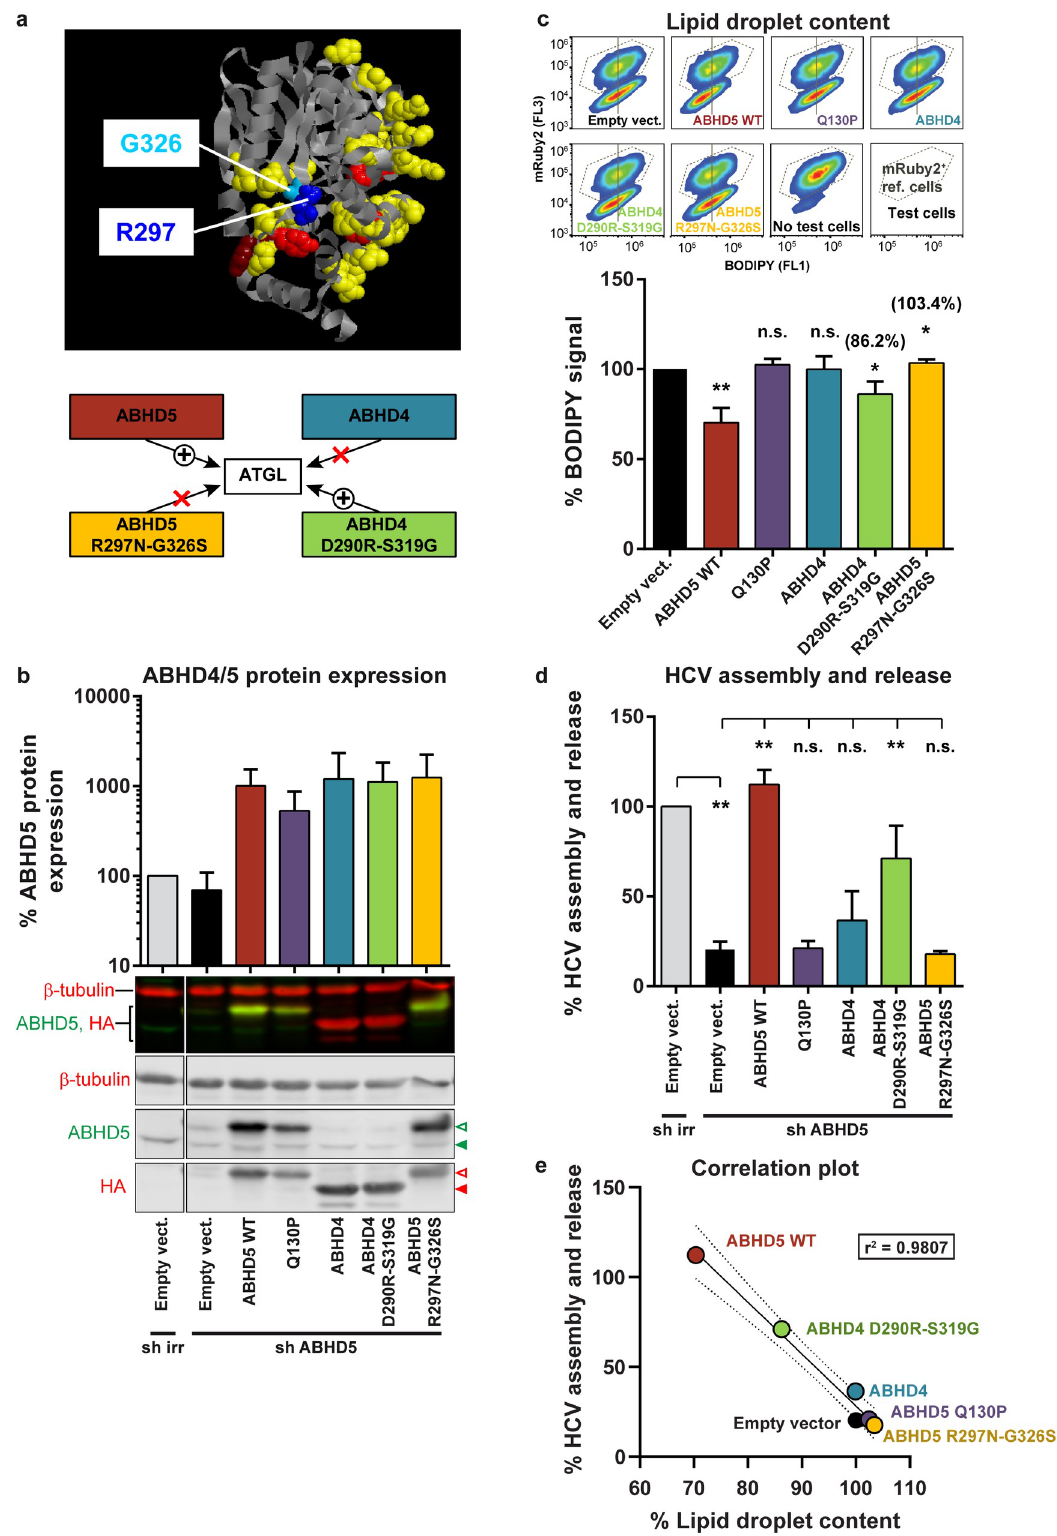
Fig 11. Transfer of the lipolytic and pro-viral functions by swapping two residues between ABHD5 and its paralog ABHD4. ( a ) Swapping two residues between ABHD4 and ABHD5 confers ATGL activation properties to ABHD4 and results in a